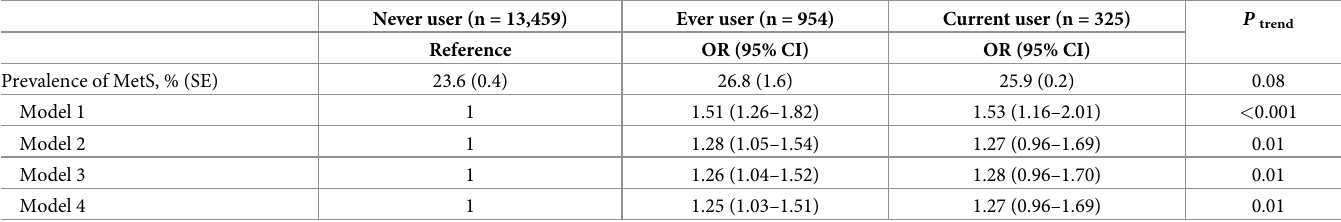
Table 3. Association between metabolic syndrome and electronic cigarette